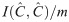
The influence shift diagrams for the degree ordering of four example networks, plotting the influence ratios (I(C^,C^)/m, I(P^,P^)/m and I(C^,P^)/m).The diagrams in the top row feature an edge-normalized x-axis where the balance point is at x = 0.5. In the second row a logarithmic axis, where x = 0.5 represents k=n, is used. The last row contains network details for the balanced edge-based partition.